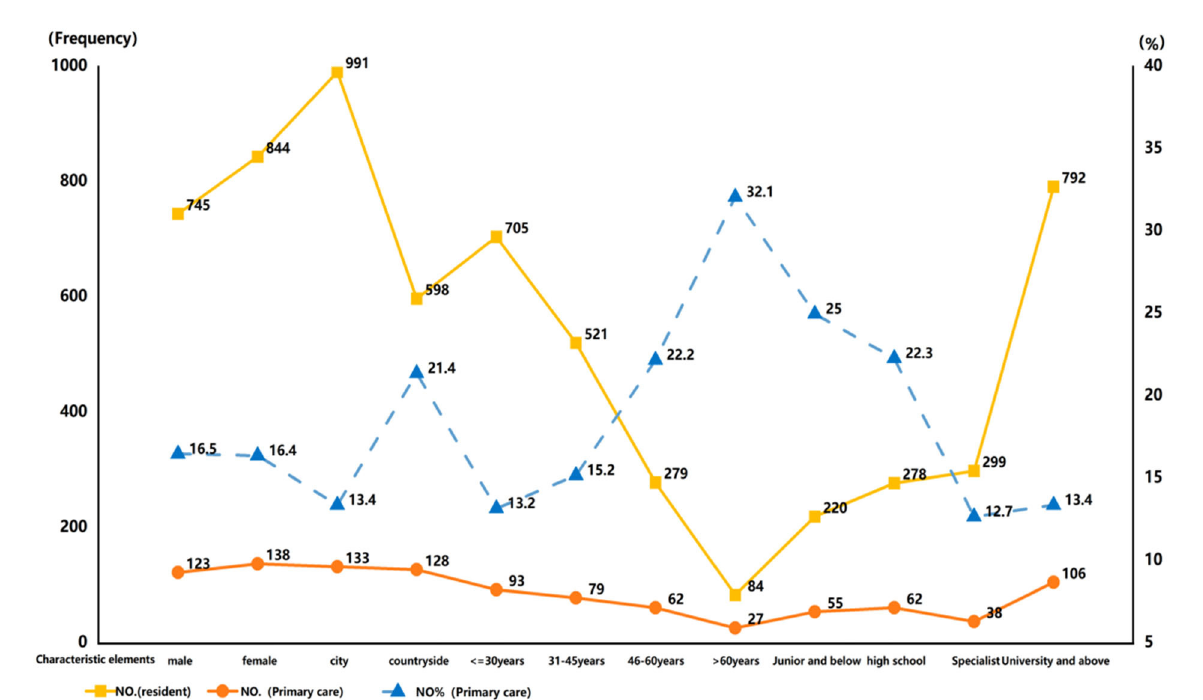
FIGURE3 Residents’ choices of medical treatment and the proportion of grassroots under the characteristic elements.